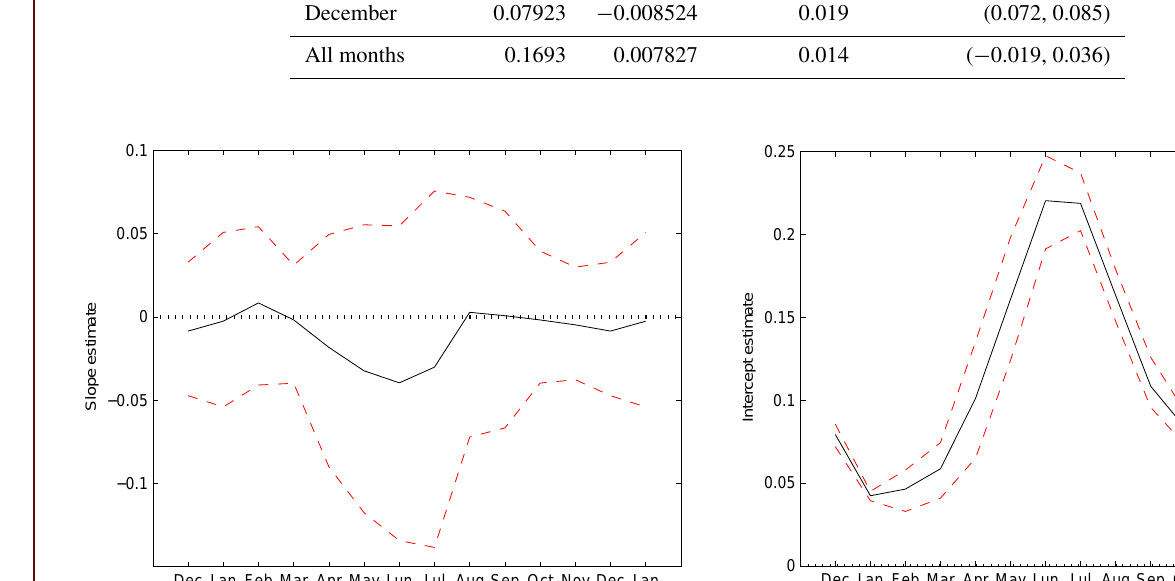
Figure 7. Time sequences from December, January, February, ..., November, December, January, showing WTS-estimated slope co- efficients with upper and lower limits from point-wise 95% boot- strap percentile confidence intervals, for the spatial standard devia- tion vs. spatial mean of the transformed data { v ( s ,t ) } . The horizon- tal dotted black line is the zero line.